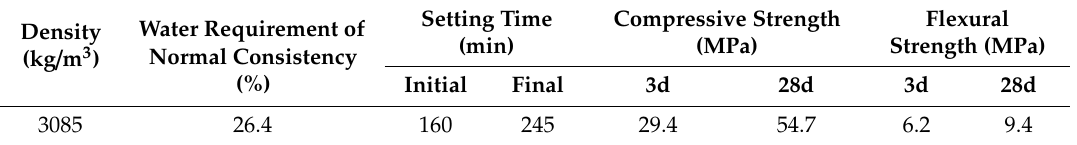
Table 1. Physical and mechanical properties of cement.